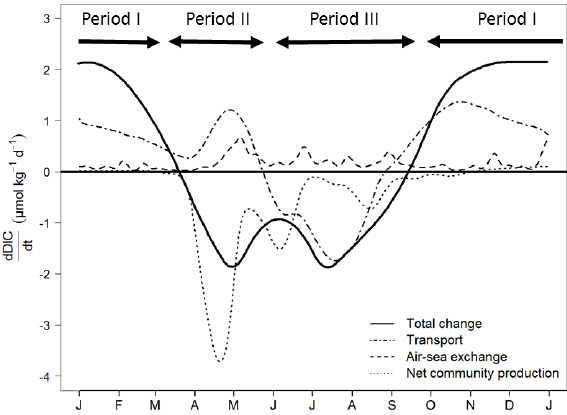
Figure 10. Overview of how different processes (transport, air–sea exchange and net community production) contribute to the temporal observed change in DIC (µmolkg − 1 d − 1 ) for the station close to the ice sheet (GF10). Uptake of CO 2 by the sea from the atmosphere is shown as a positive